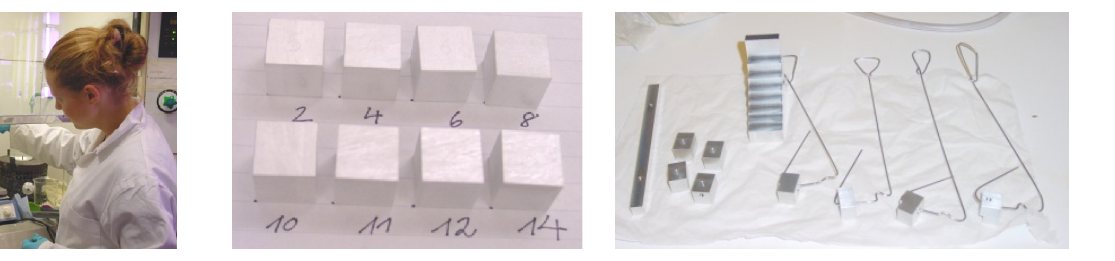
Figure 9. Artefact lined up for etching. After the etching process the single element were mounted into a fixed position (see Figure